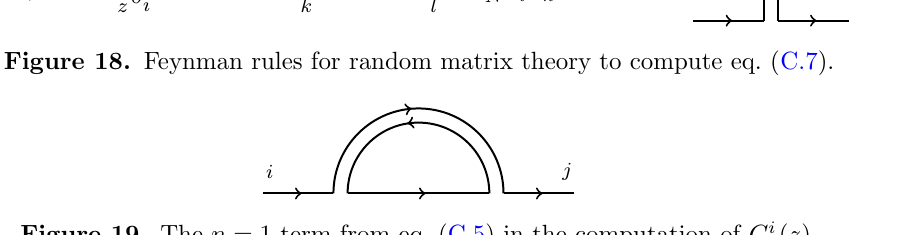
Figure 19. The n = 1 term from eq. (C.5) in the computation of G i